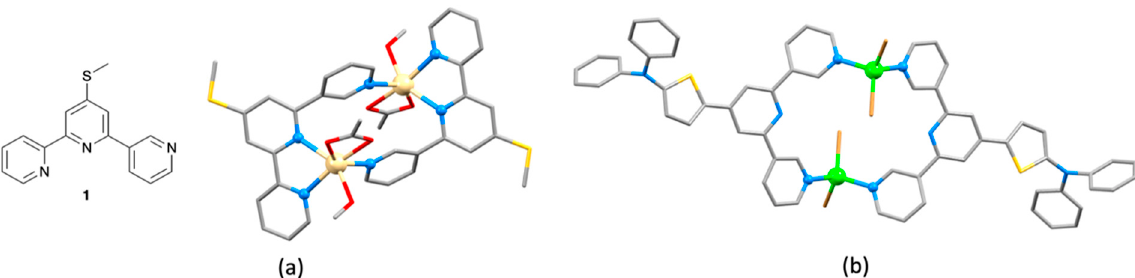
Figure 1. ( a ) The structure of ligand 1 (a derivative of 2,2 (cid:48) :6 (cid:48) ,3 (cid:48)(cid:48) -tpy) and the metallocycle [Cd 2 ( 1 ) 2 (MeOH) 2 (O 2 CMe) 2 ] 2+ , Figure 1. (a) The structure of ligand 1 (a derivative of 2,2’:6’,3” ‐ tpy) and the metallocycle [Cd 2 ( 1 ) 2 (MeOH) 2 (O 2 CMe) 2 ] 2+ , structurally characterized as the [PF 6 ] – salt (CSD refcode REFFEN). (b) An example of a 4’ ‐ functionalized 3,2’:6’,3” ‐ tpy in structurally characterized as the [PF 6 ] – salt (CSD refcode REFFEN). ( b ) An example of a 4 (cid:48) -functionalized 3,2 (cid:48) :6 (cid:48) ,3 (cid:48)(cid:48) -tpy in conformation C acting as a convergent ligand in [Zn 2 Br 4 L 2 ] where L = N,N ‐ diphenyl ‐ 5 ‐ (3,2’:6’,3’’ ‐ terpyridin ‐ 4’ ‐ yl)thiophen ‐ conformation C acting as a convergent ligand in [Zn 2 Br 4 L 2 ] where L = N,N -diphenyl-5-(3,2 (cid:48) :6 (cid:48) ,3 (cid:48)(cid:48) -terpyridin-4 (cid:48) -yl)thiophen- 2 ‐ amine (CSD refcode ELANIQ). 2-amine (CSD refcode Figure 1. (a) The structure of ligand 1 (a derivative of 2,2’:6’,3” ‐ tpy) and the metallocycle [Cd 2 ( 1 ) 2 (MeOH) 2 (O 2 CMe) 2 ] 2+ , Figure 1. (a) The structure of ligand 1 (a derivative of 2,2’:6’,3” ‐ tpy) and the metallocycle [Cd 2 ( 1 ) 2 (MeOH) 2 (O 2 CMe) 2 ] 2+ , structurally characterized as the [PF 6 ] – salt (CSD refcode REFFEN). (b) An example of a 4’ ‐ functionalized 3,2’:6’,3” ‐ tpy in structurally characterized as the [PF 6 ] – salt (CSD refcode REFFEN). (b) An example of a 4’ ‐ functionalized 3,2’:6’,3” ‐ tpy in conformation C acting as a convergent ligand in [Zn 2 Br 4 L 2 ] where L = N,N ‐ diphenyl ‐ 5 ‐ (3,2’:6’,3’’ ‐ terpyridin ‐ 4’ ‐ yl)thiophen ‐ conformation C acting as a convergent ligand in [Zn 2 Br 4 L 2 ] where L = N,N ‐ diphenyl ‐ 5 ‐ (3,2’:6’,3’’ ‐ terpyridin ‐ 4’ ‐ yl)thiophen ‐ 2 ‐ amine (CSD refcode ELANIQ). 2 ‐ amine (CSD refcode ELANIQ).